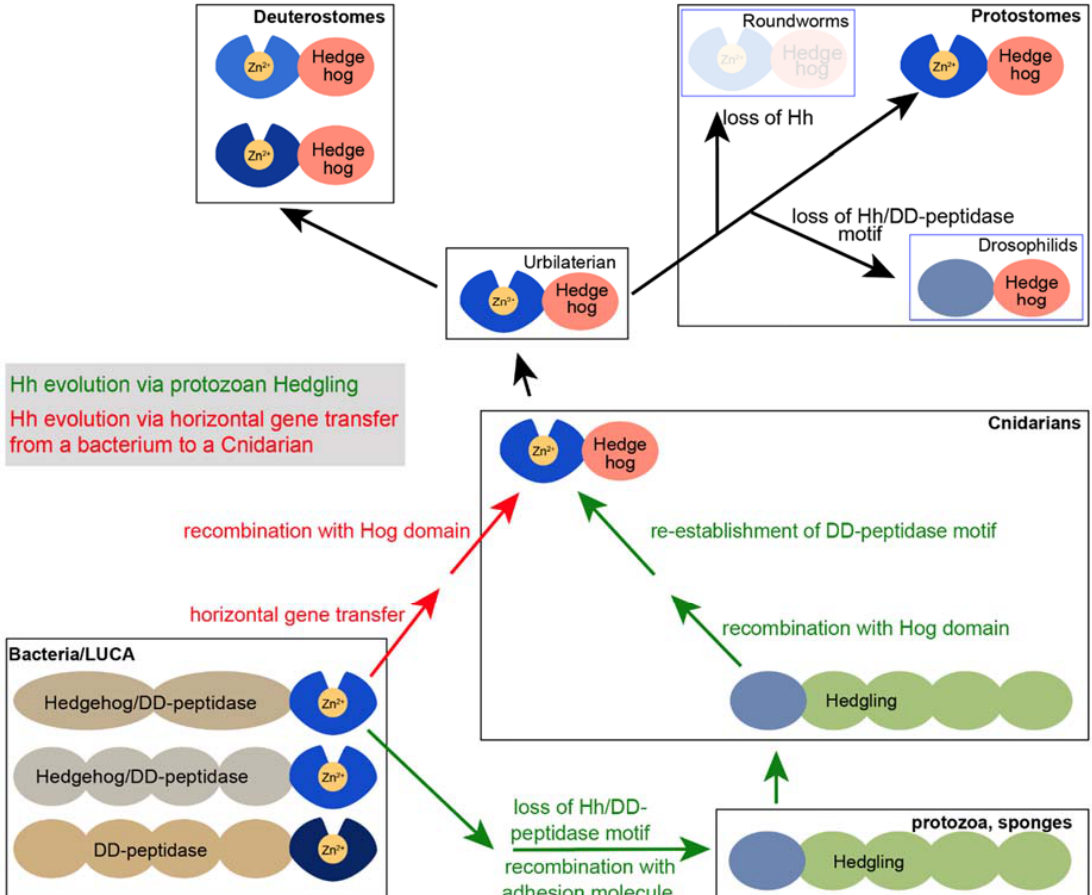
Figure 5. Models for the evolution of modern Hh proteins. The presence of both Hhs and Hedglings in Cnidarians support the model that the HhN of Hh domain arose via a recombination of the